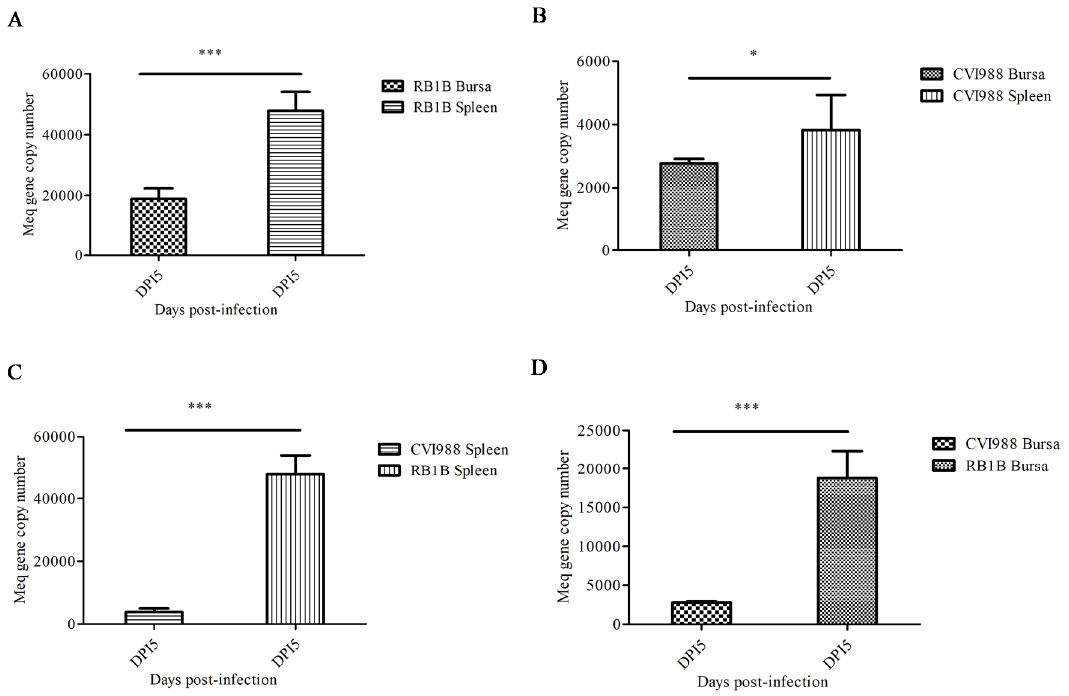
Figure 1. Replication of vvRB1B and CVI988 strains of Marek’s disease virus (MDV) in splenic and bursal lymphocytes. ( A ) The viral load in vvRB1B infected splenic and bursal lymphocytes. ( B ) The viral load in CVI988 infected splenic and bursal lymphocytes. ( C ) The comparison of replication of vvRB1B and CVI988 in bursal lymphocytes. ( D ) The comparison of replication of vvRB1B and CVI988 in splenic lymphocytes. The statistic estimates are shown as means ± SD of three independent experiments of per chicken and per indicated organ (* p < 0.05; *** p < 0.001; ns, no significance).